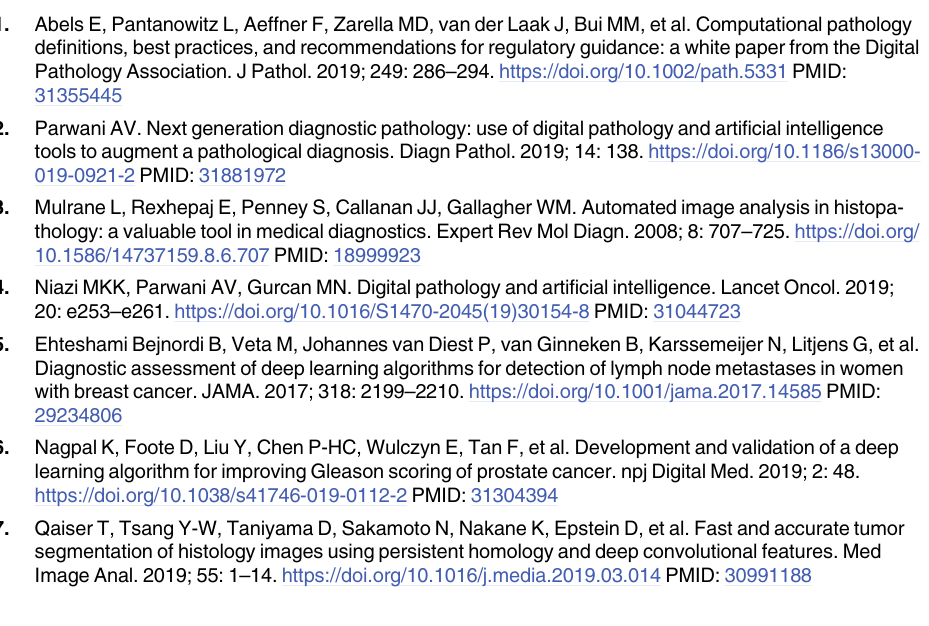
S1 Table. Tile distribution across classes in the TCGA use case training and test sets. S2 Table. Confusion matrix for the tiles in the test set of the TCGA use